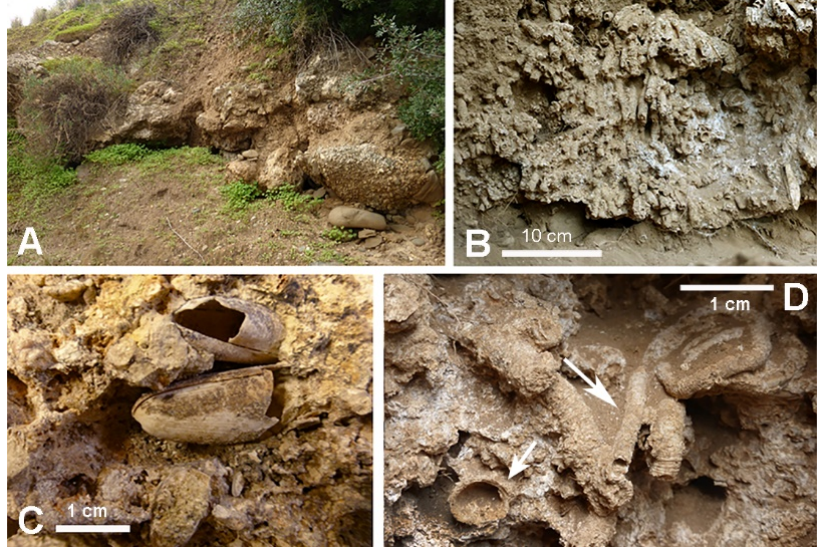
Figure 13. ( A ) Present-day aperture of the Fulco Cave with the Tyrrhenian conglomerates in the foreground. ( B ) Colonies of the scleractinian dendrophylliid Astroides calycularis with elongate corallites hanging from the ceiling. ( C ) Specimens of L. lithophaga in life position. ( D ) The bivalve Chama sp. (short arrow) and the serpulid Protula sp. (long arrow) are associated with the corals. Astroides corallites are exceptionally elongate, possibly as a response to low water motion and/or competition for space and food. The recurrent constrictions occurring on